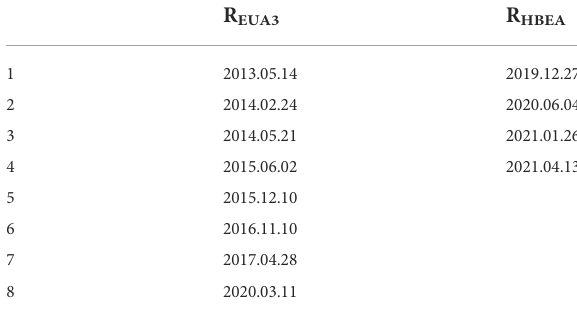
FIGURE 5 NewsimpactcurveoftheEGARCH(1,1)modelofEUAfutures returns.